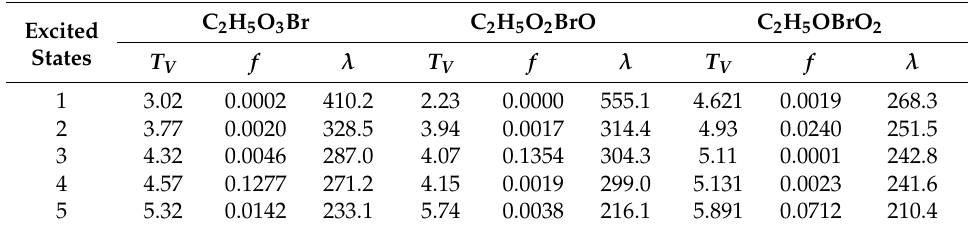
Table 3. The excitation energy T V (in eV), oscillator strength f (in atomic units) and wavelength λ (in nm) of the first five excited states of C 2 H 5 O 3 Br, C 2 H 5 O 2 BrO and C 2 H 5 OBrO 2 at